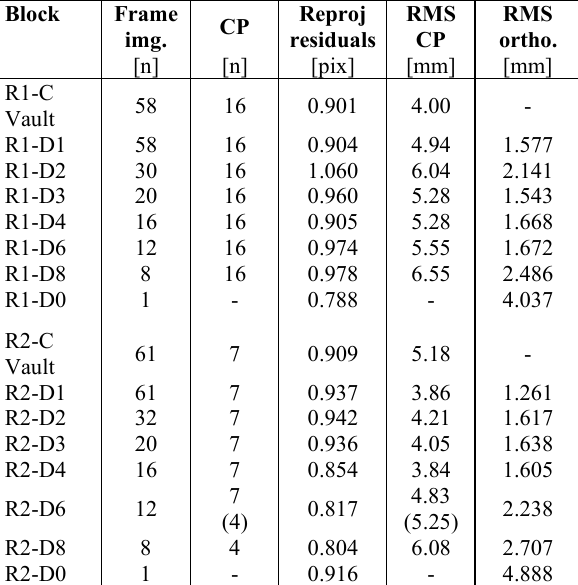
Table 4. Stats on collinearity residuals and comparison between orthophoto. In brackets the stats computed on Block R2-D6 using only 4 CP are provided for uniformity with the Block